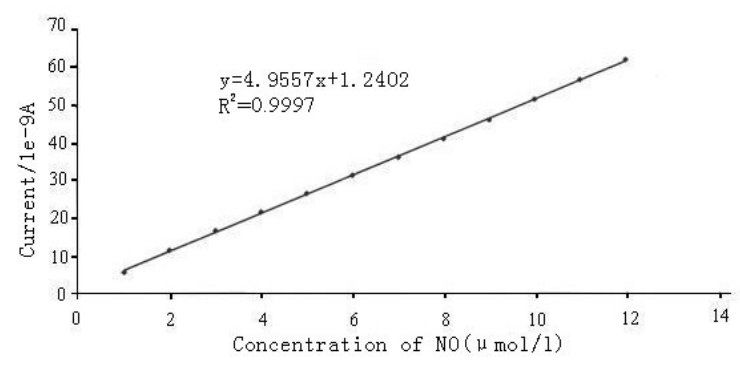
Fig. 2 . Relationship between NO concentration • 10 -6 mol/l — 10 -5 mol/l • in seawater and electrode